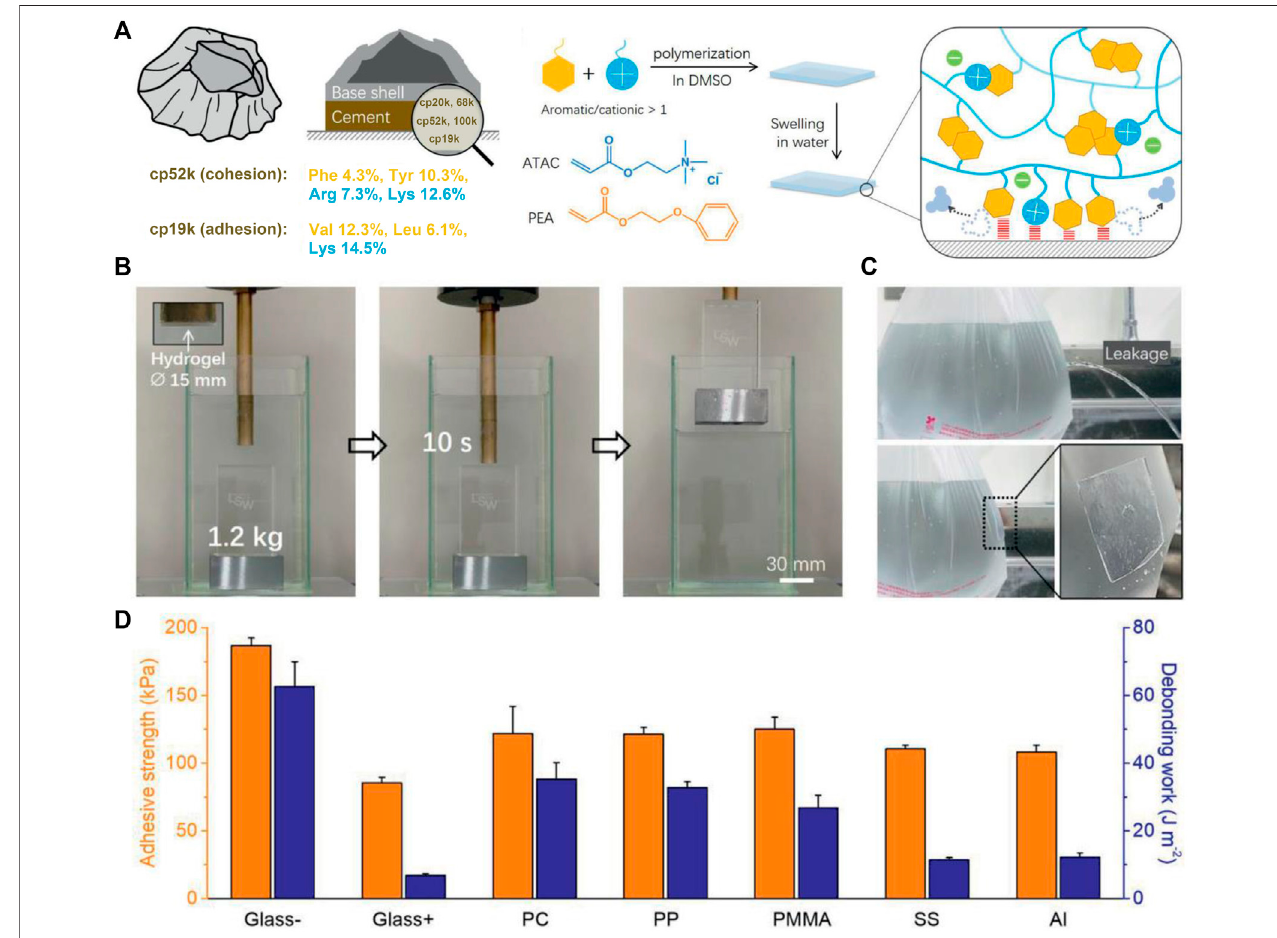
FIGURE 5 | Barnacle cement protein – inspired tough hydrogel showing superior wet adhesion property. (A) Schematic representation of the amino acid compositionsofcp52kandcp19kandthefabricationprocessofthehydrogel. (B) Photographsofthehydrogel fi rmlyadheringtoanunderwaterobjectandallowingitto be lifted out of the water. (C) Photographs show that the hydrogel immediately repairs a plastic bag of leaking water. (D) Adhesion strength of the hydrogel against different substrates in water. Adapted with permission from Fan et al. (2021). Copyright 2021, John Wiley and Sons.